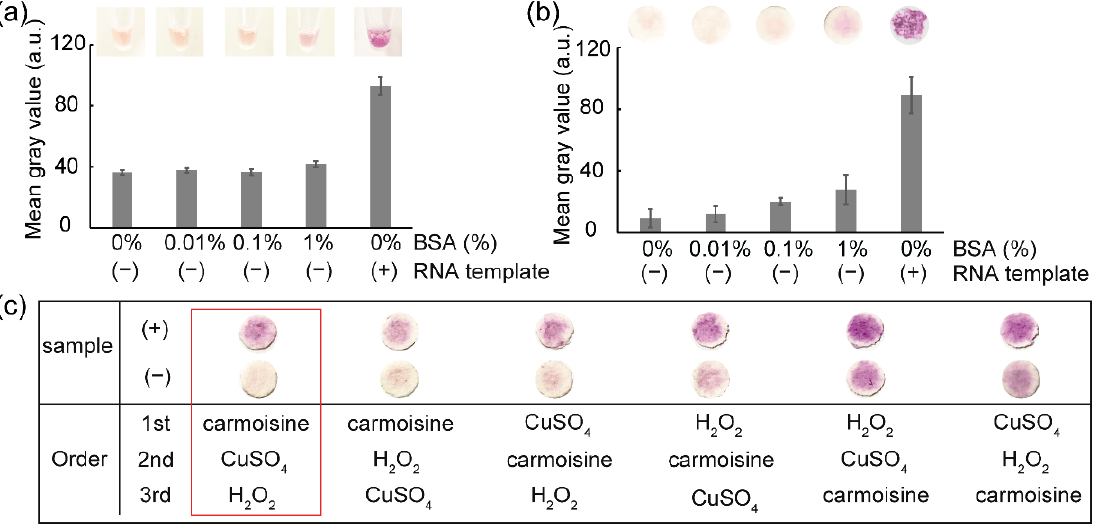
Figure 4. The colorimetric detection of pathogens. The results show the effect of BSA for ( a ) in-tube and ( b ) paper-based colorimetric detection: (−) RT-LAMP reaction not containing RNA template and (+) RT-LAMP reaction containing RNA template. Image ( c ) shows the effect of the sequence of the reagent’s addition in colorimetric detection.